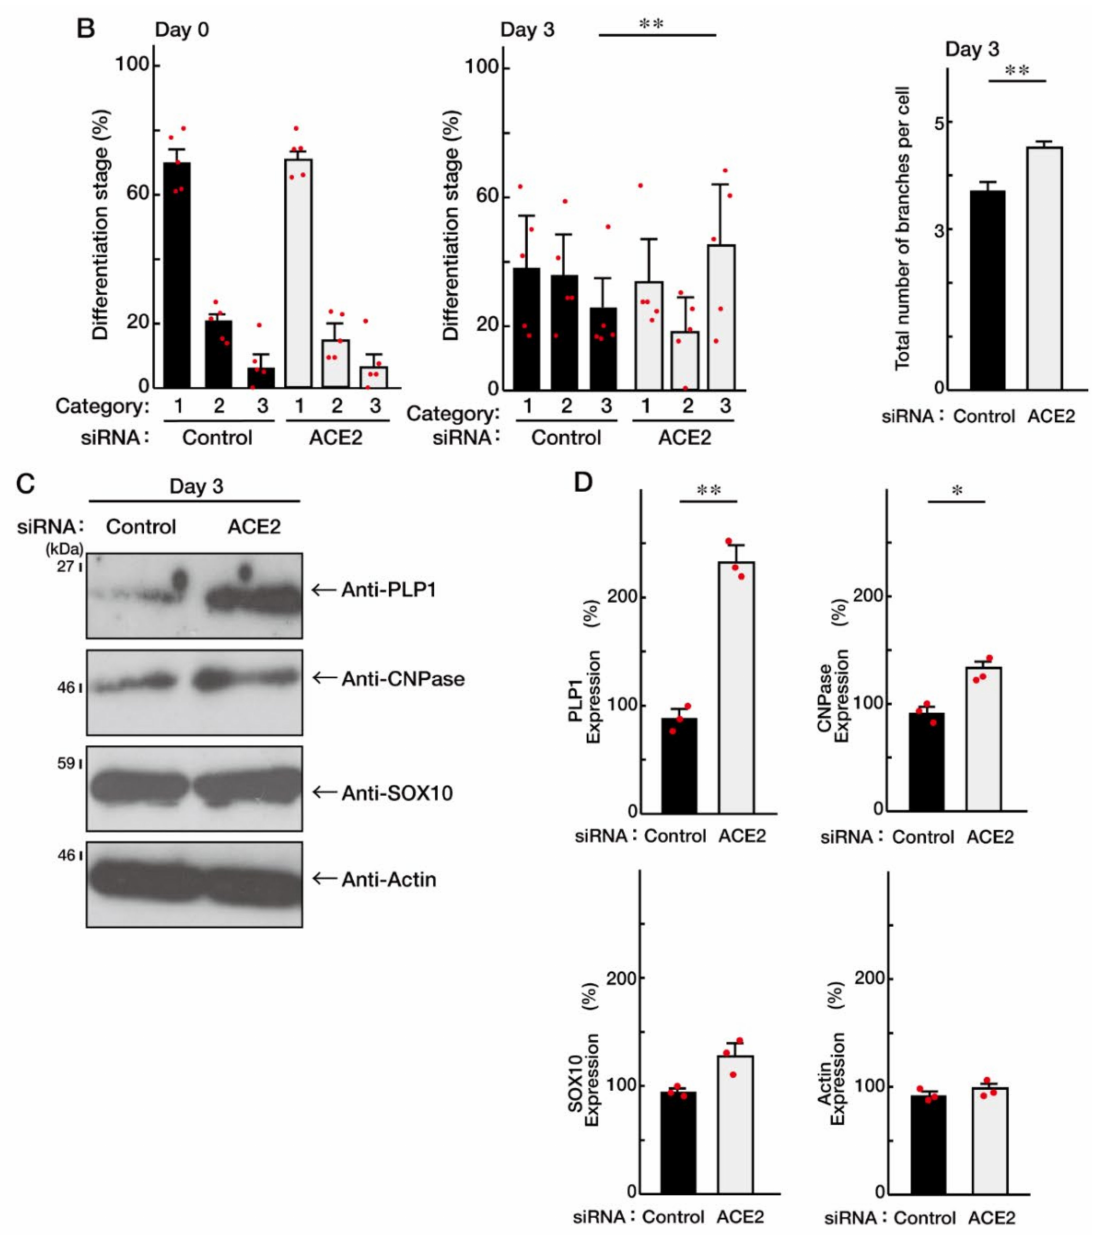
Figure 1. Knockdown of ACE2 by siRNA promotes oligodendroglial cell morphological differ- entiation. ( A , B ) FBD-102b cells were transfected with control or ACE2 siRNA and were allowed to be differentiated for 0 or 3 days. Differentiation efficiencies were divided into three categories and depicted in graphs (**, p < 0.01; n = 5 fields). Category 1 included cells with fewer than two primary branches; Category 2 included cells with fewer than three primary branches and without secondary branches; and Category 3 included cells with more than three primary branches and with secondary branches as well as with widespread membranes. Category 1 was considered to be the phenotypes before differentiation, whereas Category 3 was considered to be the differentiated phenotypes. Category 2 corresponded to these intermediate phenotypes. The number of branches in cells is also counted and shown (**, p < 0.01; n = 50 cells). ( C , D ) Cells at 3 days following the induction of differentiation were collected, lysed, and immunoblotted with an antibody against PLP1, CNPase, SOX10, or actin. Immunoreactive band intensities were also compared to be depicted in graphs (**, p < 0.01 and *, p < 0.05; n = 3